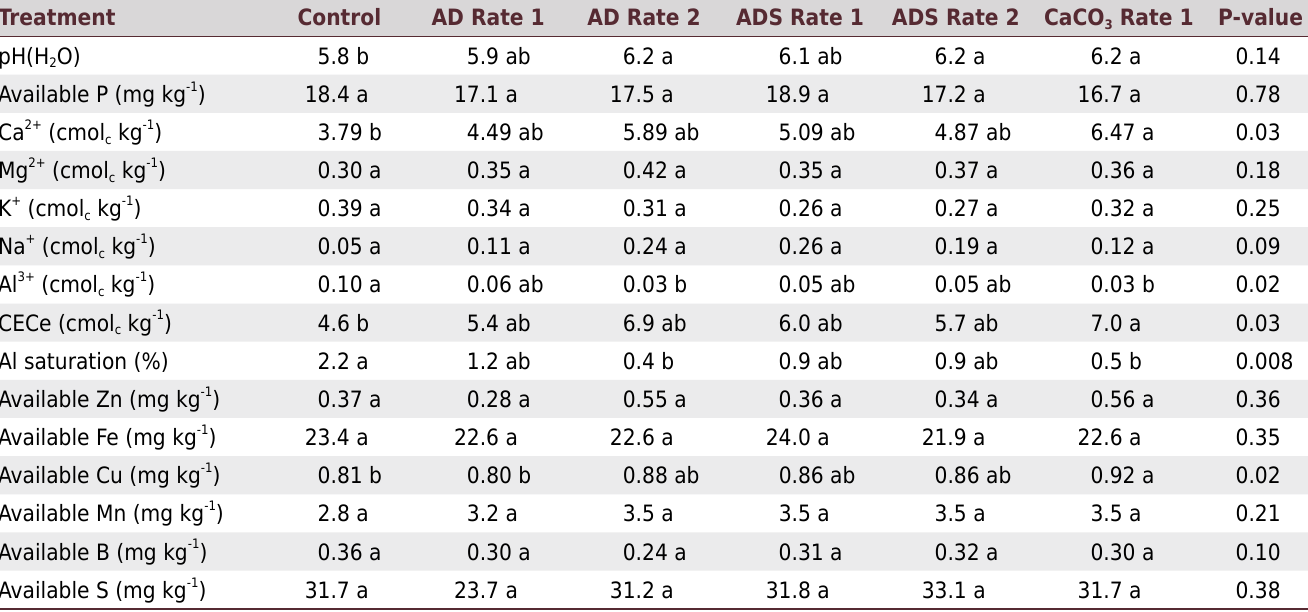
Table 3. Soil chemical properties at the Santa Rosa location 360 days after the application of six soil acidity control treatments